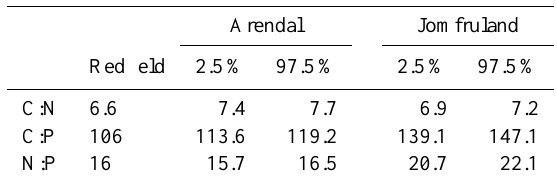
Table 2. Confidence Intervals (CI) of null model (overall mean) of C:N, C:P and N:P. The C:N:P ratio is deemed as significantly different from the Redfield ratio if the respective Redfield ratio is not included in the